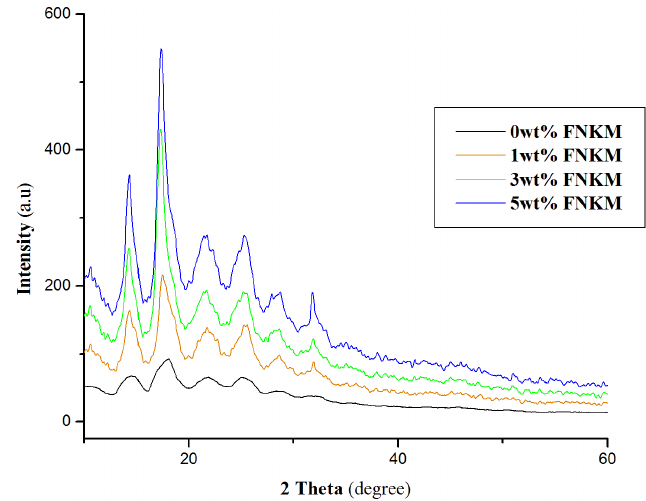
Figure 6. X-ray diffraction (XRD) pattern of 0, 1, 3, 5 wt % FNKM loaded CA membranes.